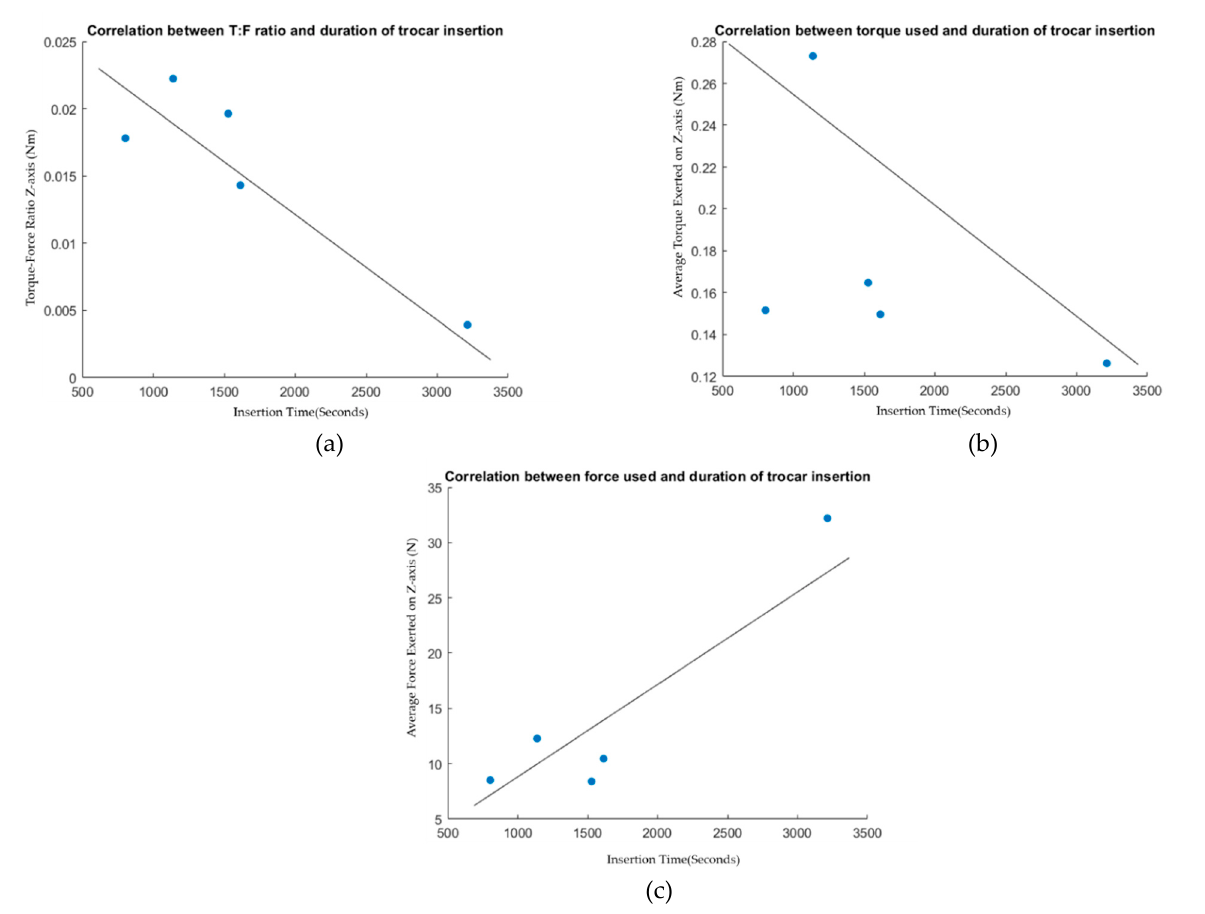
Figure 7. Scatter plots show correlation between force and torque factors to procedural outcome and time to perform the action. ( a ) Shows correlation between T: F and duration of trocar insertion; ( b ) shows correlation between torque used and trocar insertion time; ( c ) shows correlation between force exerted during procedure and procedural time. force exerted during procedure and procedural